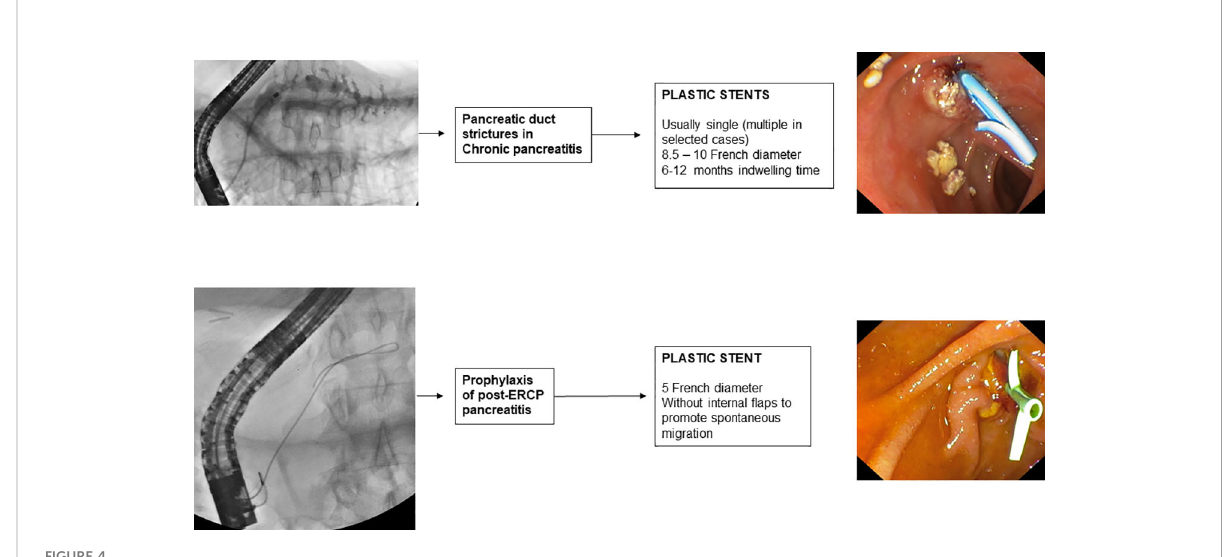
FIGURE 4 Pancreatic stenting and choice of the stent.